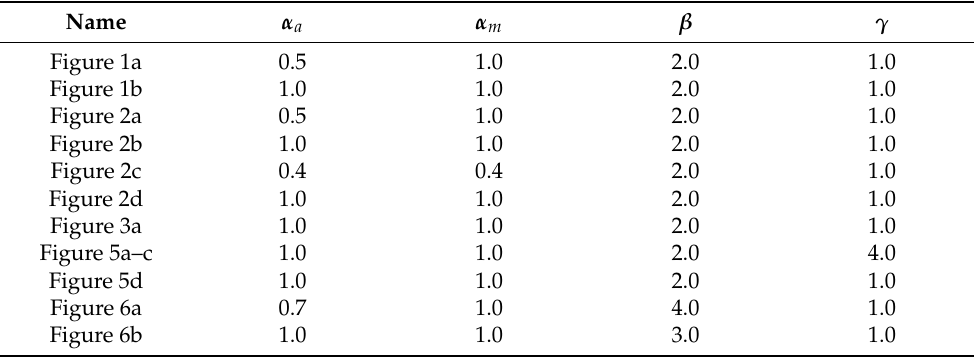
Figure 1. Examples of simple trajectories with an overshoot, converging on F 1 (left, ( a )) and F 2 (right, ( b )). Lines in red indicate the variable S , in blue the variable D , in yellow the activator a and in green the activator m . In ( b ), the coordinates of the fixed point F 2 are given in colored dots. Parameters of the modeling can be found in Tables 2 and 3. Initial conditions ( t = 0) differ significantly from the fixed point values recovered at long times t (cid:39) 10, except for D , because of the overshoot. Table 2. Choice of parameters concerning biochemical